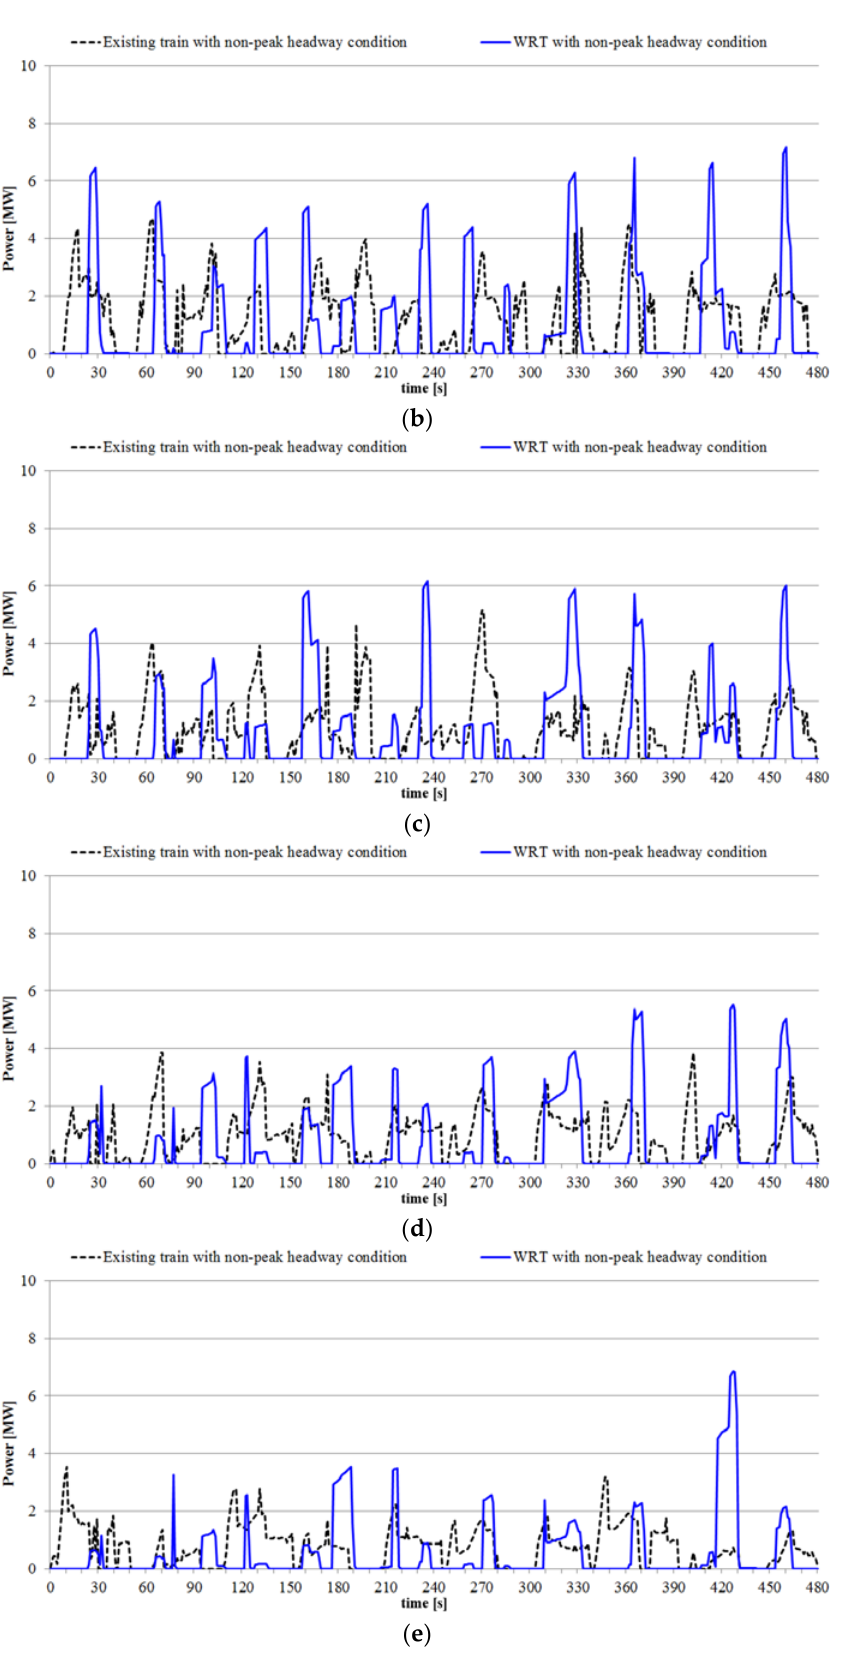
Figure 9. Results of substation power for the non-peak headway condition. ( a ) Electrical power for Substation 1; ( b ) Electrical power for Substation 2; ( c ) Electrical power for Substation 3; ( d ) Electrical power for Substation 4; ( e ) Electrical power for Substation 5.